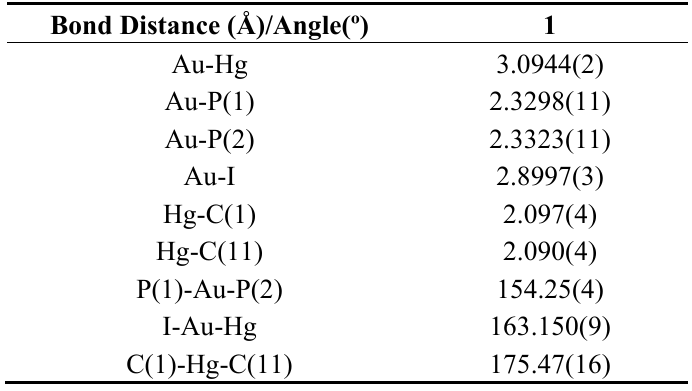
Figure 1. Crystal structure of compound 1 .Thermal ellipsoid are set at 35% probability. Table 1. Selected bond lengths (Å) and angles (°) for complex 1